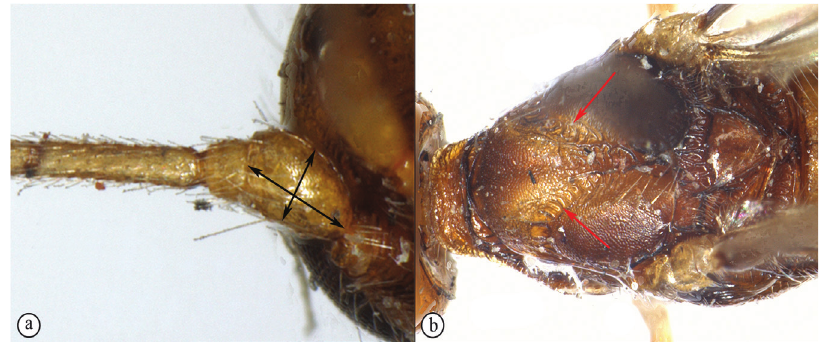
Re-description of the genus. Head not depressed, high, transverse. Ocelli arranged in triangle with base slightly larger than its sides. Vertex laterally of ocelli and frons laterally with distinct but not high longitudinal protuberances. Frons distinctly concave, with fine median longitudinal carina. Eyes glabrous. Occipital carina dorsally complete, fused ventrally with hypostomal carina. Malar suture rather distinct and complete. Clypeus without lower flange. Hypoclypeal depression small and round. Postgenal bridge wide. Maxillary palp short, 6-segmented, sixth segment about as long as fifth segment; labial palpi 4-segmented, third segment long. Antenna weakly claviform, all flagellar segments (especially apical ones) distinctly compressed. Scape of antenna wide and short, without apical lobe or basal constriction, its ventral